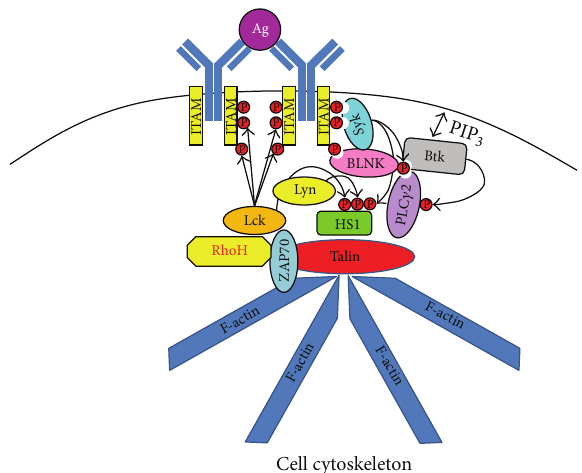
Figure 3: Possible roles of ZAP70, RhoH, and HS1 in BCR signaling in CLL cells. Schematic showing the potential role of ZAP70 as a scaffolding protein for Lck, RhoH, talin, and HS1 at the immunological synapse formed when the BCR is cross-linked on CLL cells. HS1 becomes hyperphosphorylated by Lyn, Syk, and Lck and plays a role with RhoH in regulating cytoskeletal